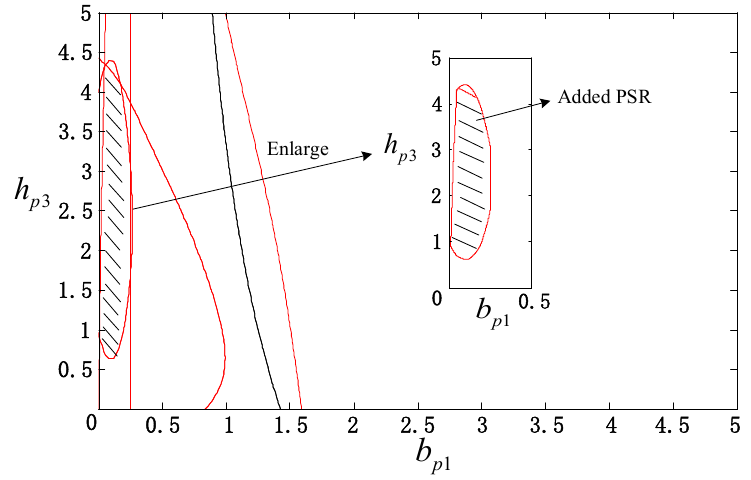
Figure 5. The PSR of h p3 -b p1 (parameter equilibrium point: h p3 = 2.41, b p1 = 0.12).